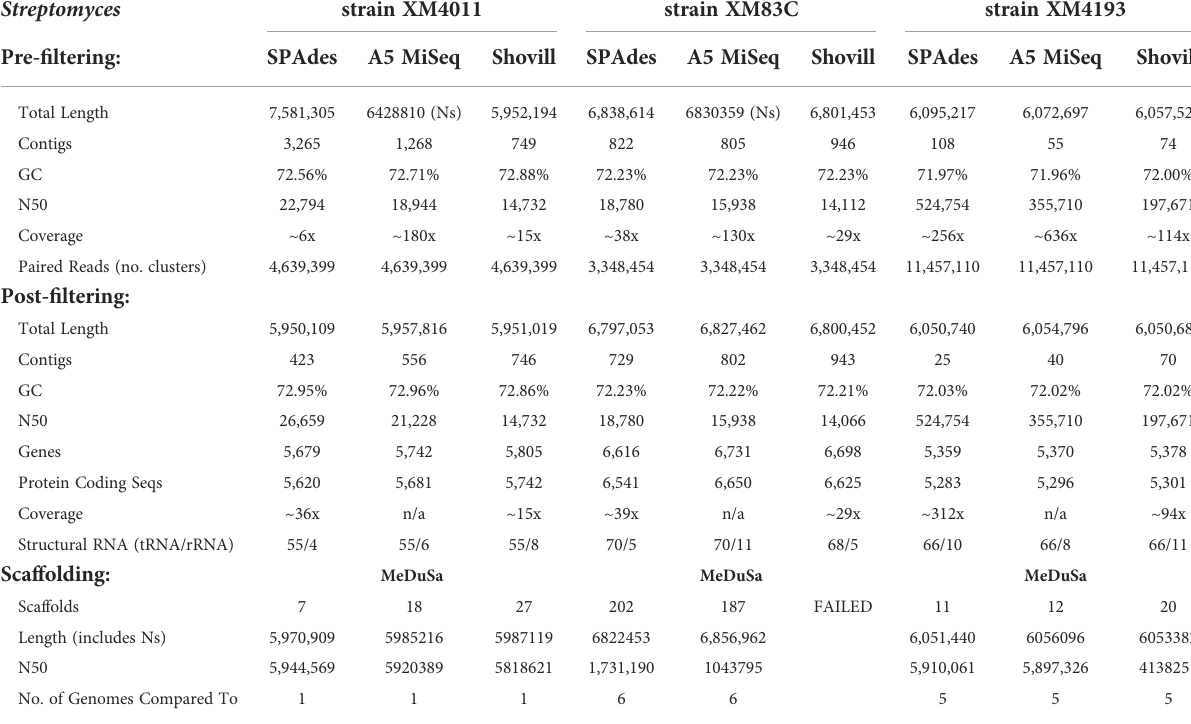
TABLE 5 Comparative assembly statistics for Streptomyces strains.